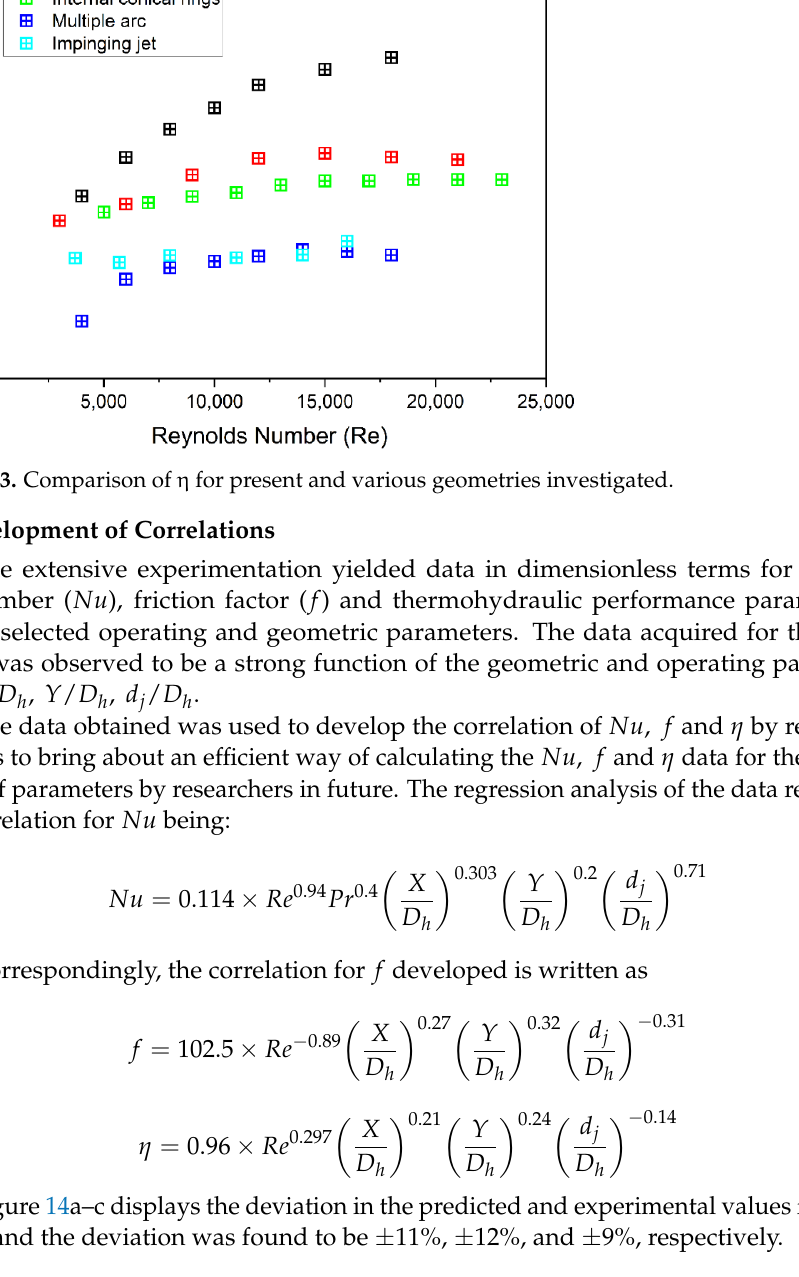
, ( b ) (cid:24)/(cid:22) and ( c ) (cid:25)/(cid:22) (cid:20) /(cid:22) (cid:23) (cid:23)